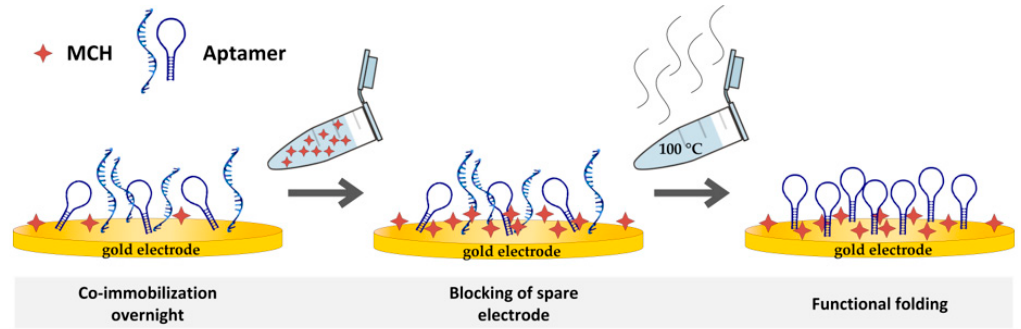
Figure 1. Schematic illustration of biosensor preparation. Co-immobilization step overnight, mercaptohexanol (MCH) blocking, and boiling step. mercaptohexanol (MCH) blocking, and boiling